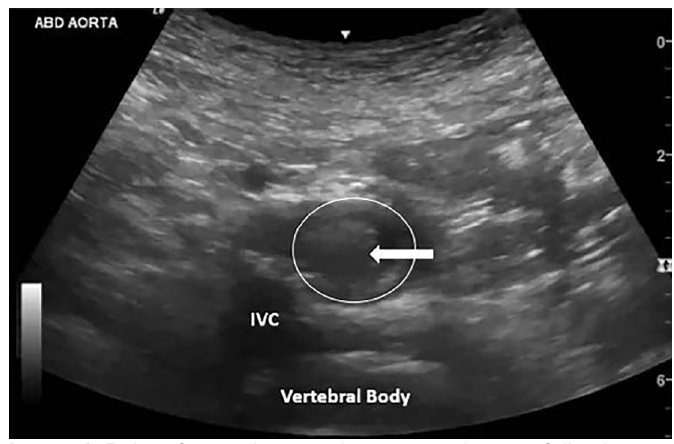
Image 1. Point-of-care ultrasound transverse image of distal aorta (white circle) with hyperechoic intraluminal content (white arrow), representing